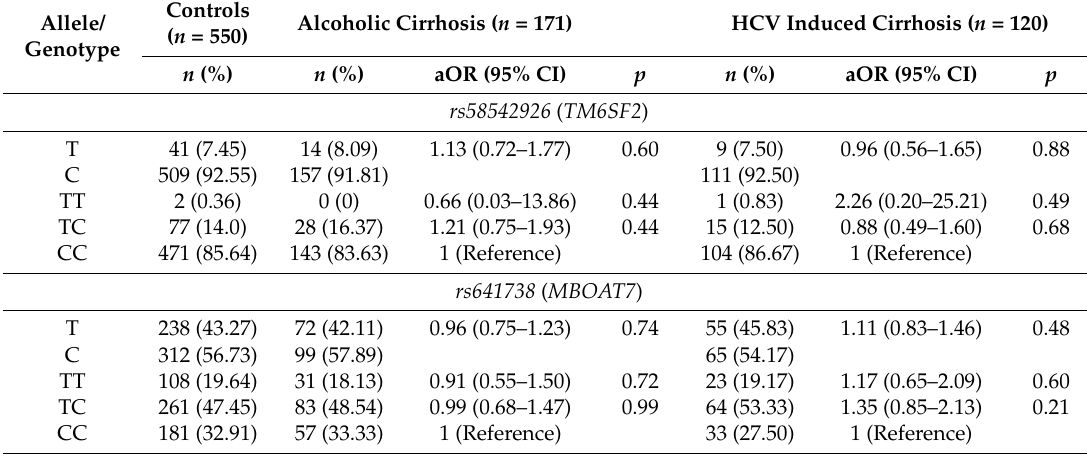
Table 3. Distribution of the TMS6SF2 and MBOAT7 SNPs alleles and genotypes in alcohol and HCV induced liver cirrhosis